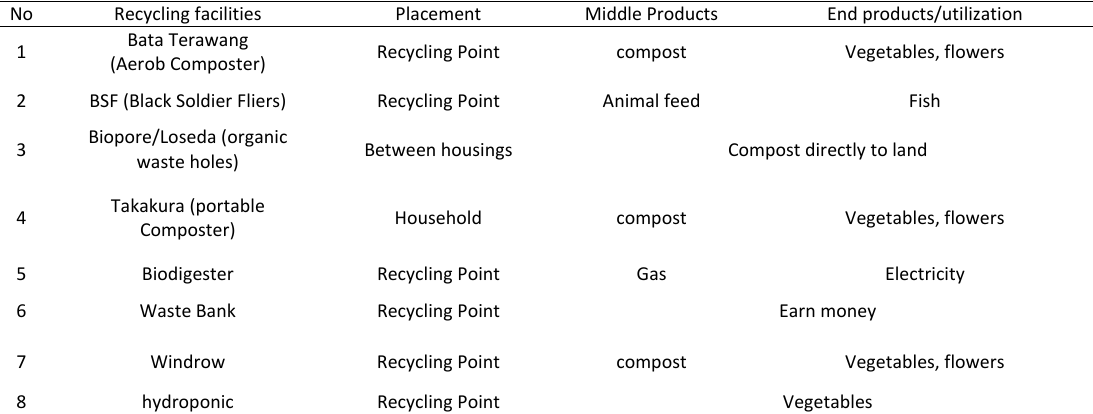
Table 7: Recycling facilities, the placement, and the end products